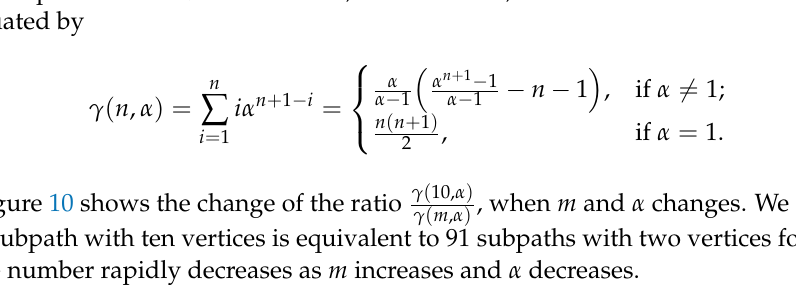
Table 1. An LCP array.